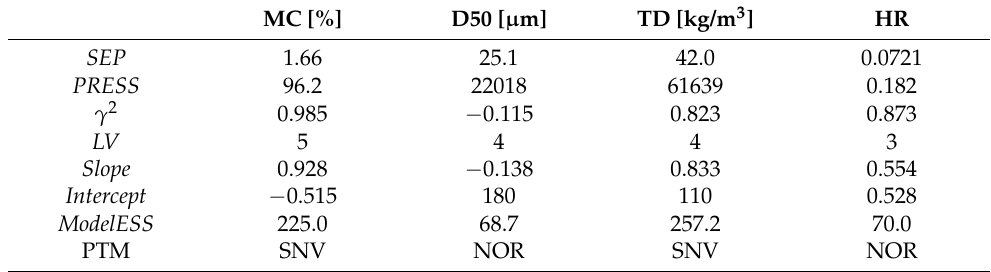
Table 4. Validation result of the best-fitting PLSR calibration models to predict pharmaceutical properties of the HSWG granules based on external NIRS data sets. SEP is the standard error of prediction; γ 2 is the coefficient of determination based on the external validation data; slope and intercept are the slope and y-intercept of the regression line in the plots between the measured and predicted values, and ModelESS is the fitting index of the